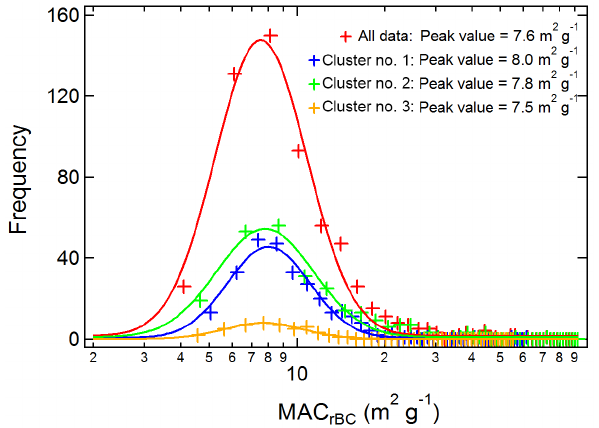
Figure 9. Frequency distributions of the mass absorption cross sec- tions of refractory black carbon (MAC rBC ) for the campaign and for air masses defined by trajectory cluster.